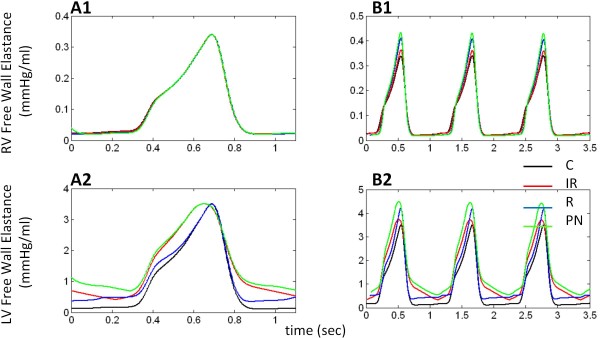
Model Free Wall Elastance Curves with Loss of Neural Feedback. RVF and LVF elastance curves with no baroreflex-mediated augmentation of contractility (Panels A1-A2) (model parameter Fcon), and with no heart rate neural control (Panels B1-B2) (model parameters FHRs and FHRv). With Fcon fixed at mean steady state control levels and no feedback control, RVF elastance does not change, peak elastance remains same as control in all cases. LVF elastance with R-type LVDD exhibits slower rise to peak (unseen in elastance with Fcon in Figure 8). With no FHRs and FHRv, heart rate is unchanged with LVDD.